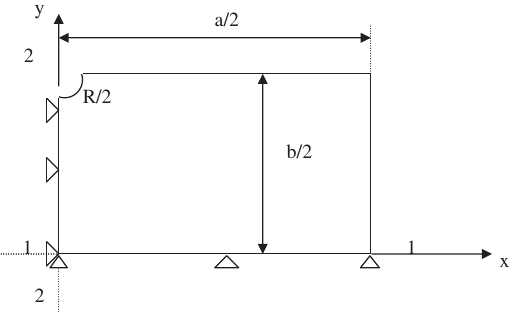
Figure 2 Boundary conditions for the finite element